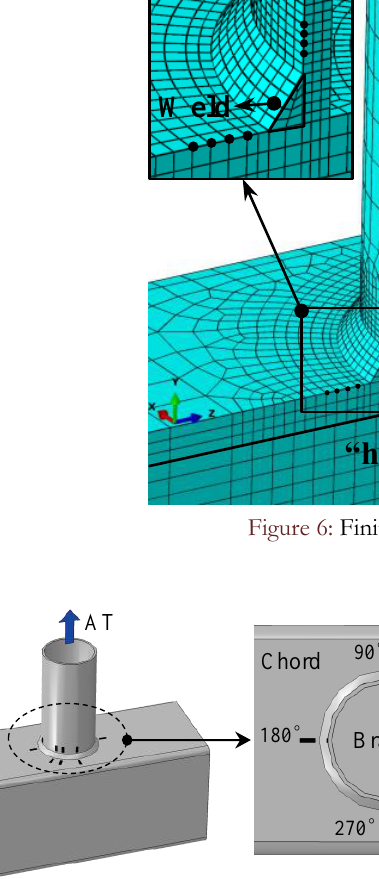
Figure 7: Condition of Axial Tension. Figure 8: Condition of In-plane bending moment.